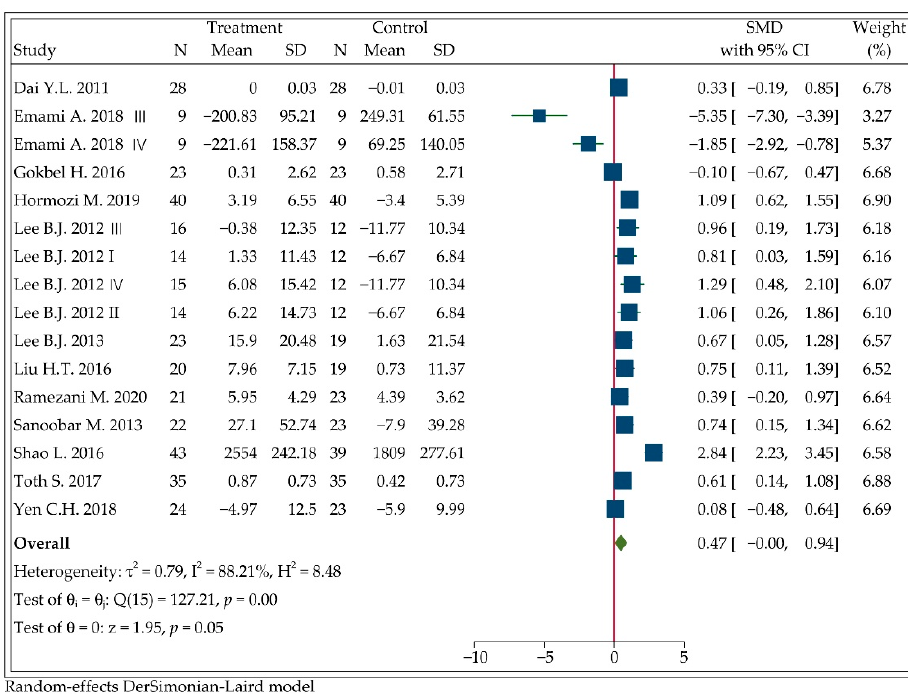
Figure 4. Forest plot of the meta-analysis on the effect of CoQ10 supplementation on net changes of SOD. Table 4. Subgroup analyses of CoQ10 supplementation on